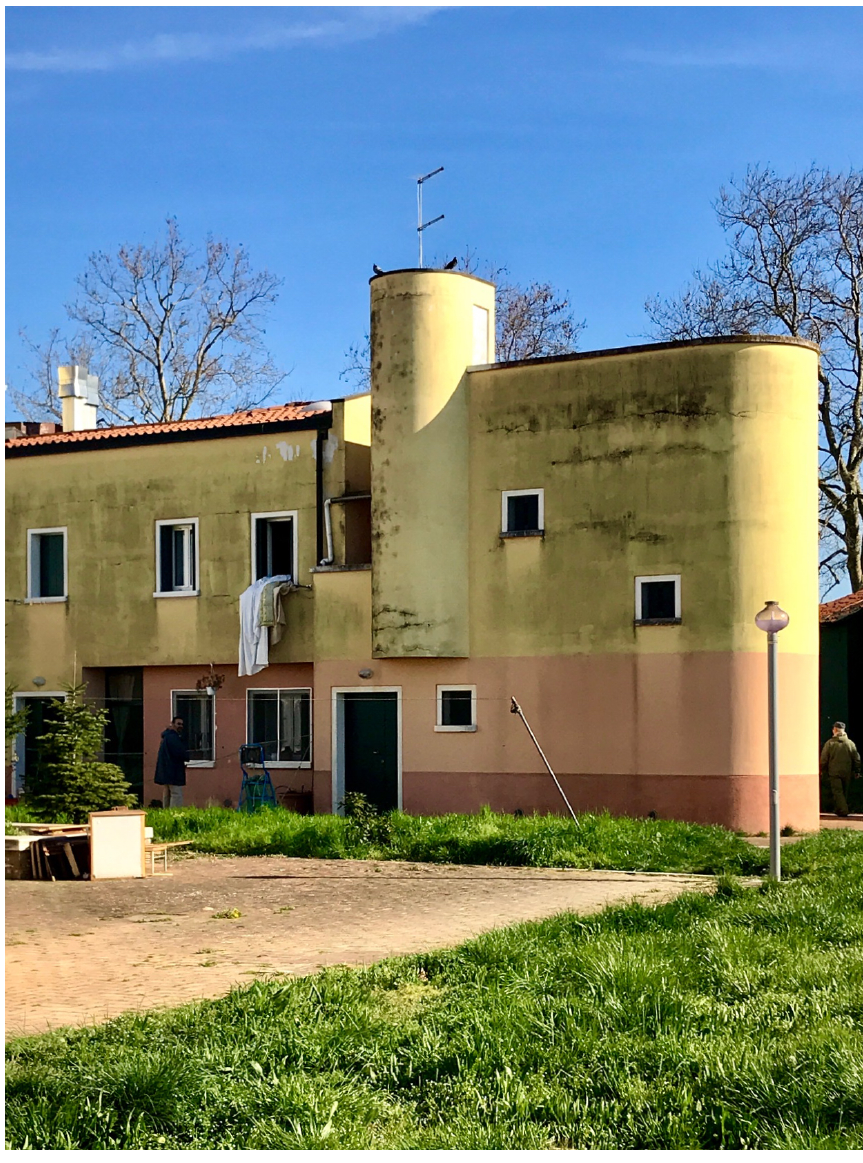
An example of the placement of the floor version of the street-lamp in Mazzorbo. Photo by Francesca Berni,